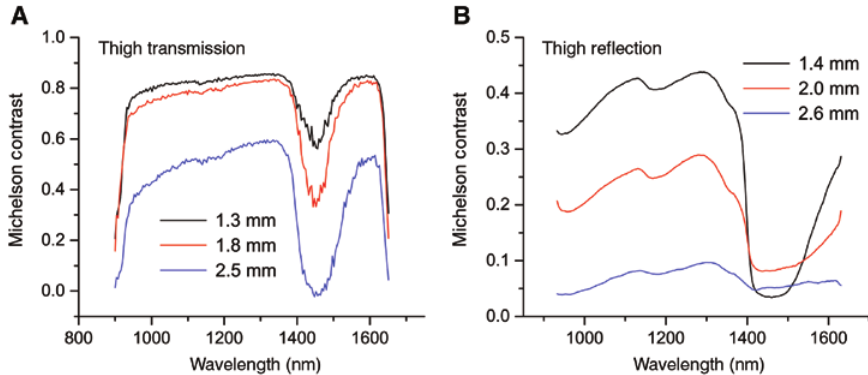
Figure 1: Transparency of biological tissue in